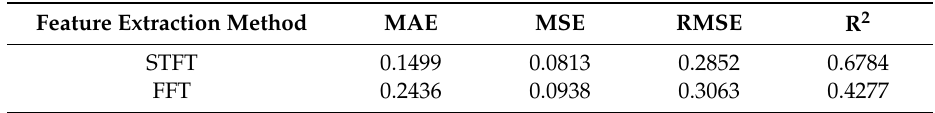
Table 3. Statistical indexes of prediction results. STFT, short-time Fourier transform; FFT, fast Fourier transform.